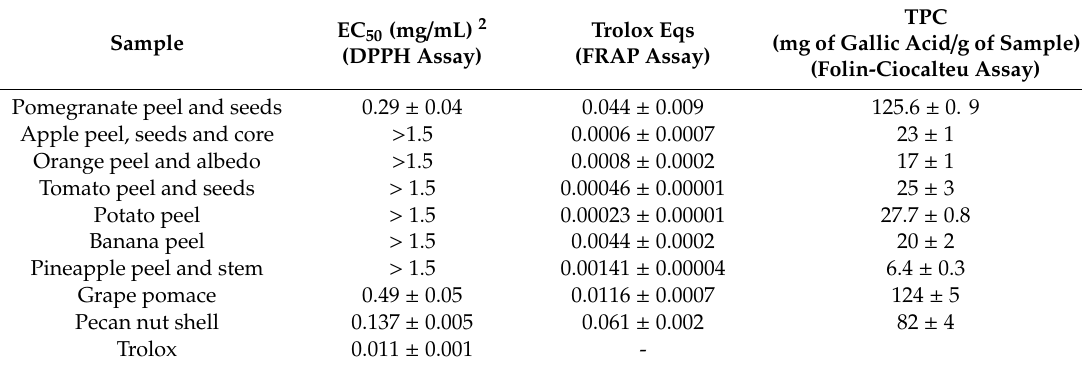
Table 1. Antioxidant properties of agri-food byproducts. 1